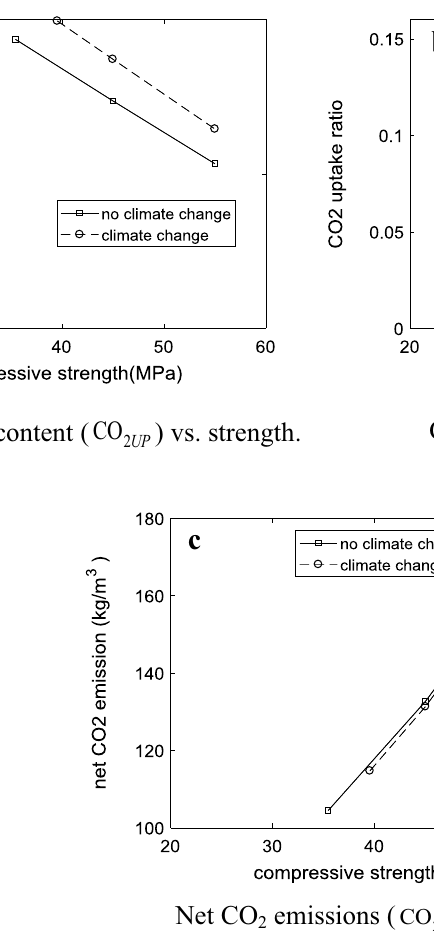
Fig. 6 Effect of strength on CO 2 uptake content ( CO 2 UP ), CO 2 uptake ratio ( CO 2 UP / Co 2 − em ), and net CO 2 emissions ( CO 2 net ).